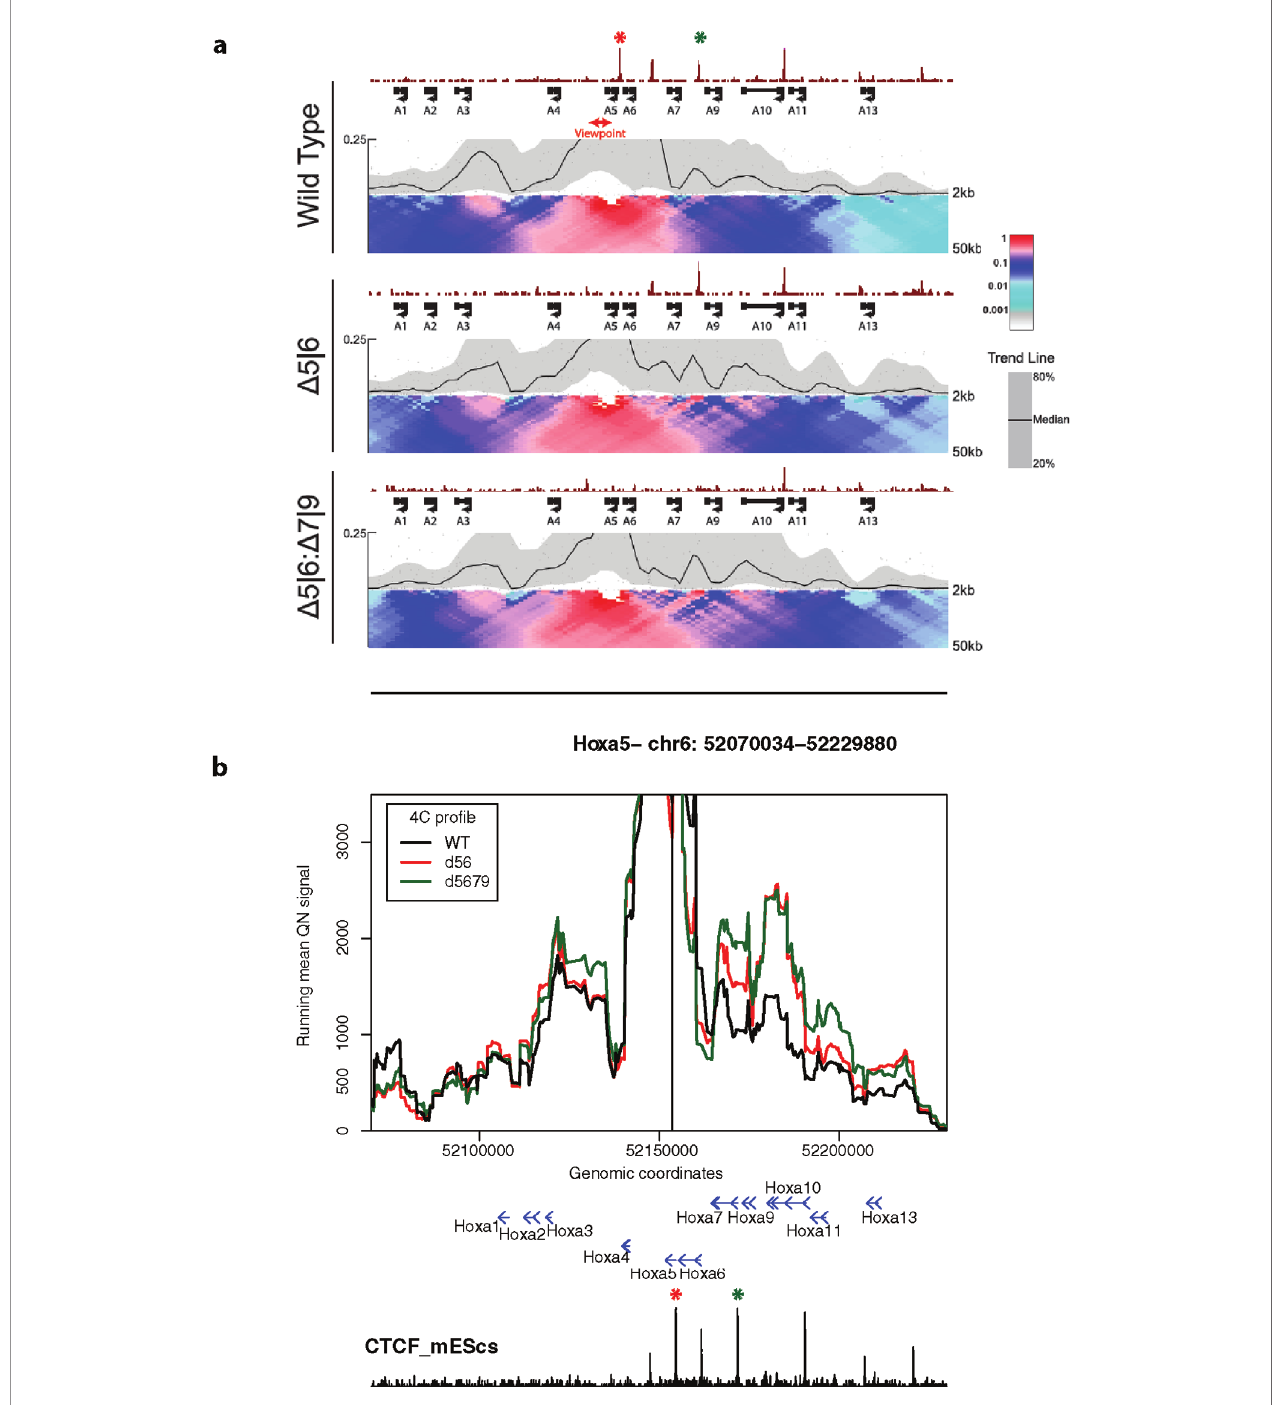
FIGURE 6 | 4See exploration can uncover previously overlooked features of chromatin topology. (A) Reproduced Supplemental Fig 7A from Narendra et al. (2015), used with permission. 4C pro fi les from the Hoxa5 bait are shown as domainogram heat maps for wild-type ES cells (top), as well as lines that have had deletions of one CTCF site (middle; site of deletion denoted by red asterisk) or two (bottom; additional deletion site denoted by green asterisk). The CTCF ChIP-seq pro fi le is shown above the 4C sets. No chromatin topology differences are apparent between these cell lines, and the original study concluded that spatial phenotypes only occurred on cell differentiation (Narendra et al., 2015). (B) The same data, processed and plotted using 4See. The position of the Hoxa5 bait is denoted by a black vertical line, and gene position (blue arrows) and the ES CTCF ChIP-seq pro fi le (black) is shown underneath the 4C plots. Red and green asterisks denote the positions of the single and double CTCF site deletions, as for (A) . In this plot, CTCF-dependent restriction of interactions between Hoxa5 and more caudal regions (e.g. the gene body of Hoxa10 ) seems